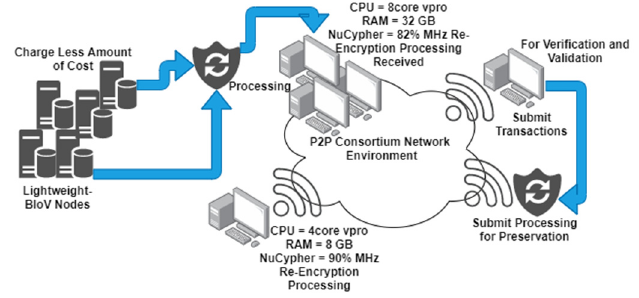
Figure 3. Criteria for IoV Node Evaluation.